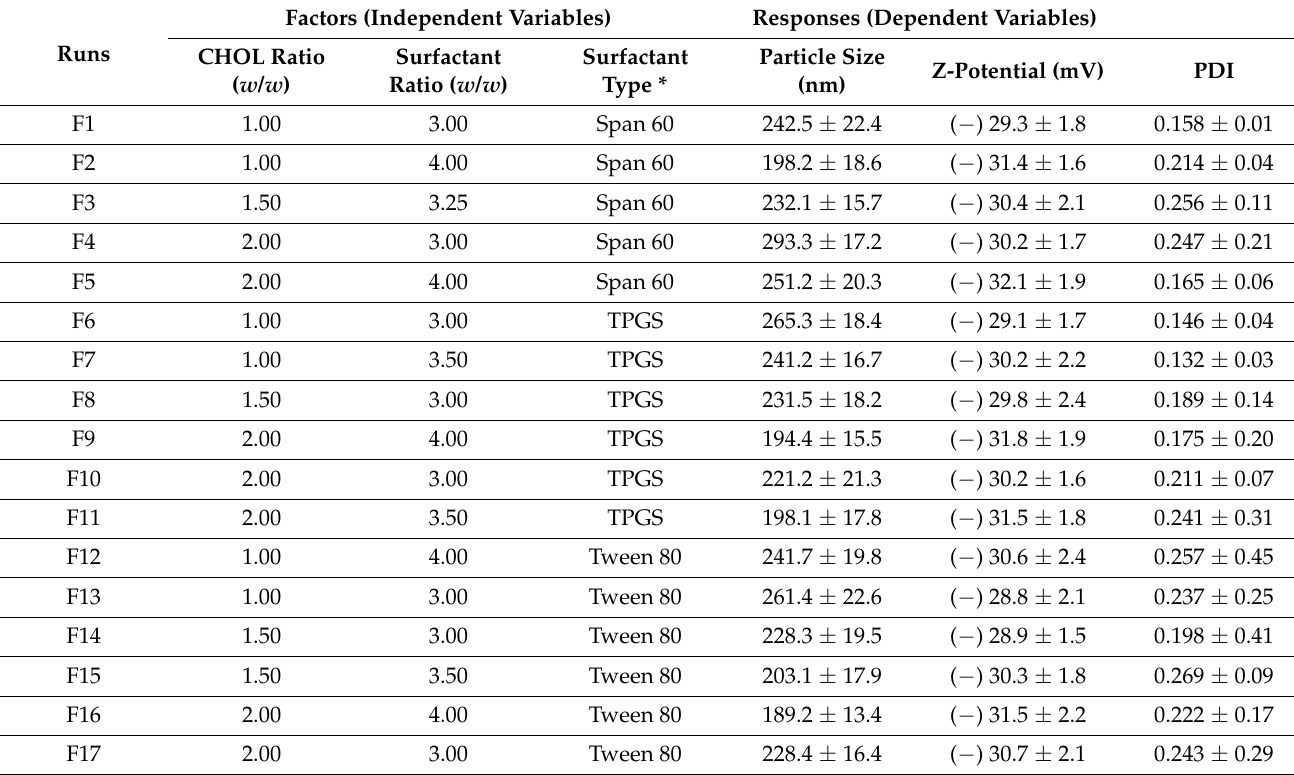
Table 1. Experimental runs, independent and dependent variables of the factorial experimental design of drug-free niosomes.